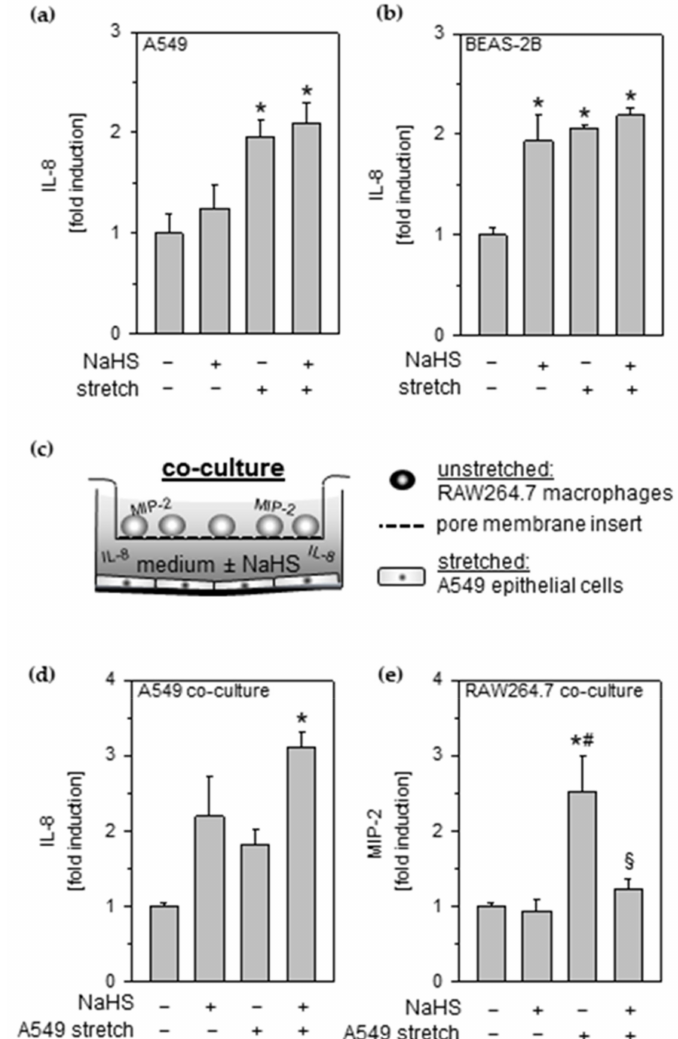
Figure 1. Effects of cyclic stretch and hydrogen sulfide on lung epithelial cells and on inflammatory signaling between epithelial cells and macrophages. Lung ( a ) A549 or ( b ) BEAS-2B epithelial cells were stretched and incubated with 1 mM NaHS, as indicated. The amounts of IL-8 in cell medium supernatant were determined by ELISA. ( c ) Setup for co-culture experiments. ( d ) A549 epithelial cells were stretched in co-culture and incubated with 1 mM NaHS, as indicated, and ( e ) RAW264.7 macrophages were grown in cell culture inserts with granted access to A549 cell culture medium. ( d ) The amounts of IL-8 released from human A549 and ( e ) MIP-2 released from murine RAW264.7 in cell medium supernatant were determined by ELISA. Data represent means ± SEM for n = 3/group. Analysis of variance (Tukey’s post hoc test), * p < 0.05 vs. control; # p < 0.05 vs. control + NaHS; § p < 0.05 vs.